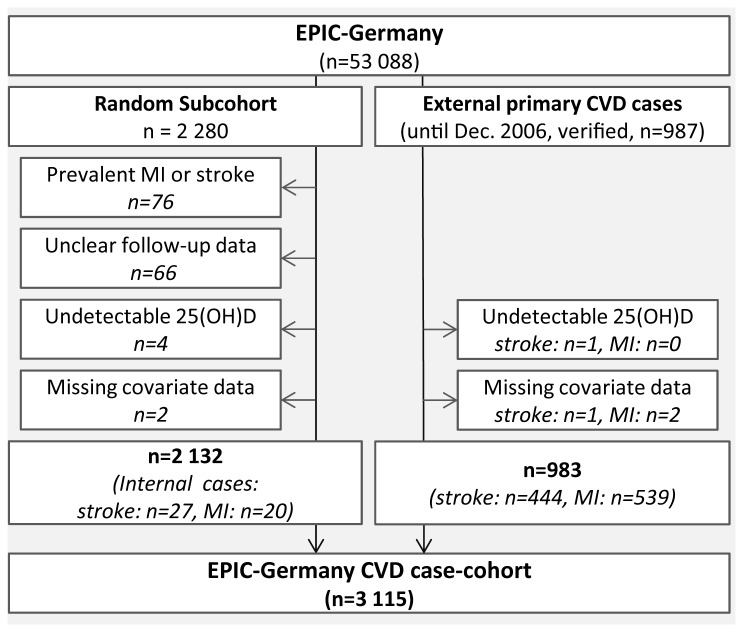
Flow chart indicating exclusions due to prevalent CVD and missing values.